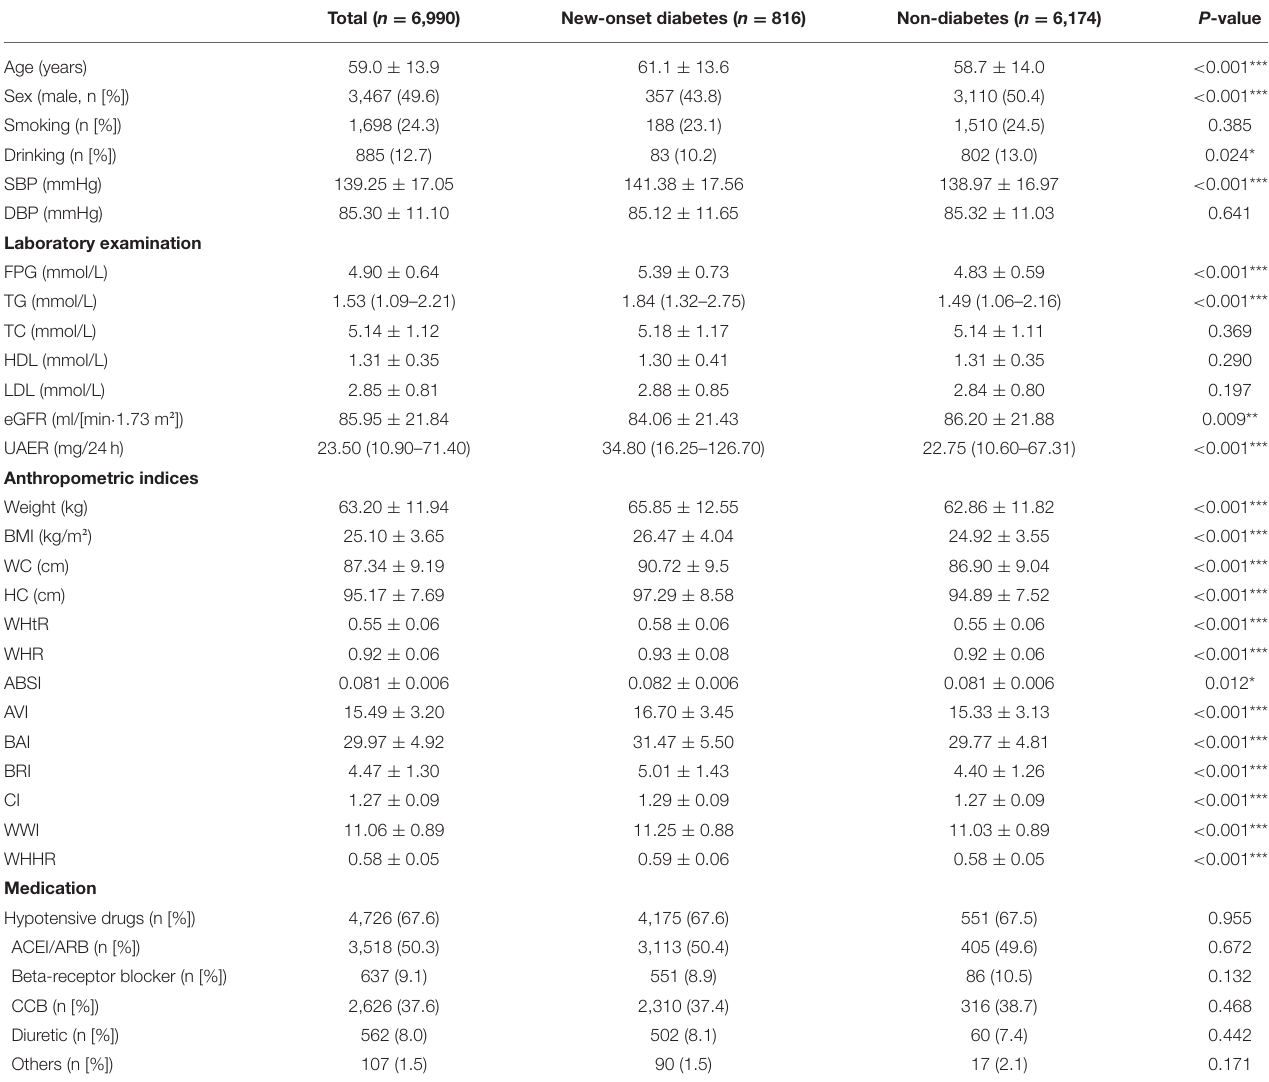
TABLE 1 | Baseline characteristics between subjects with and without diabetes. Total ( n = 6,990) New-onset diabetes ( n =